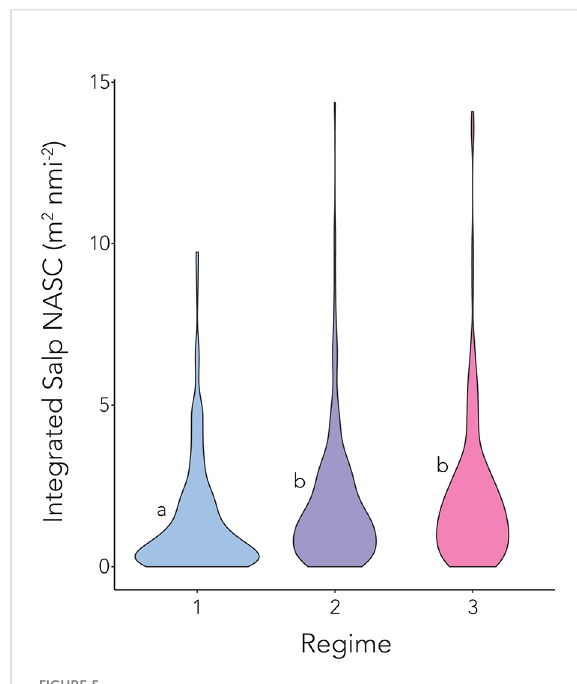
FIGURE 5 Mean integrated salp NASC (calculated from integrated PRC NASC over the top 500 m) between the (1) early, (2) mid, and (3) late season regimes. Lowercase letters represent signi fi cant differences between season